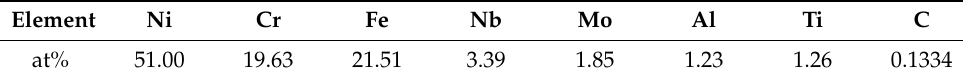
Table 1. Inconel 718 powder composition in this work.